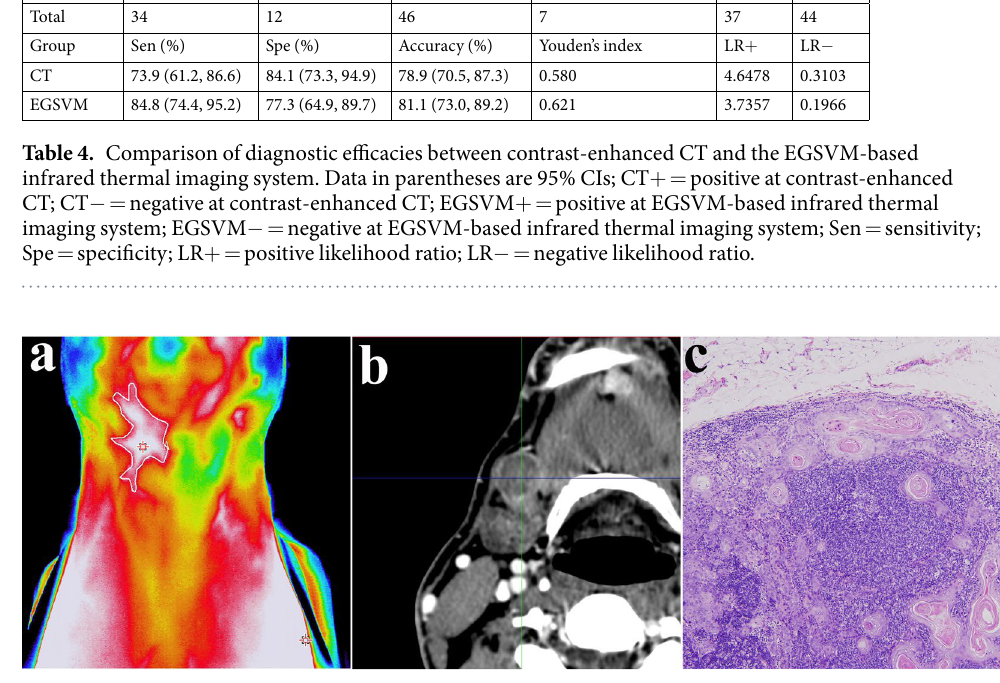
Figure 4. Representative case correctly confirmed with both IR imaging and contrast-enhanced CT. ( a ) Elevated surface temperature and increased vascular density on the right side using IR imaging; ( b ) Metastatic lymph node in contrast-enhanced CT; ( c ) Microscopic appearance of metastatic lymph nodes (hematoxylin and eosin staining, original magnification ×